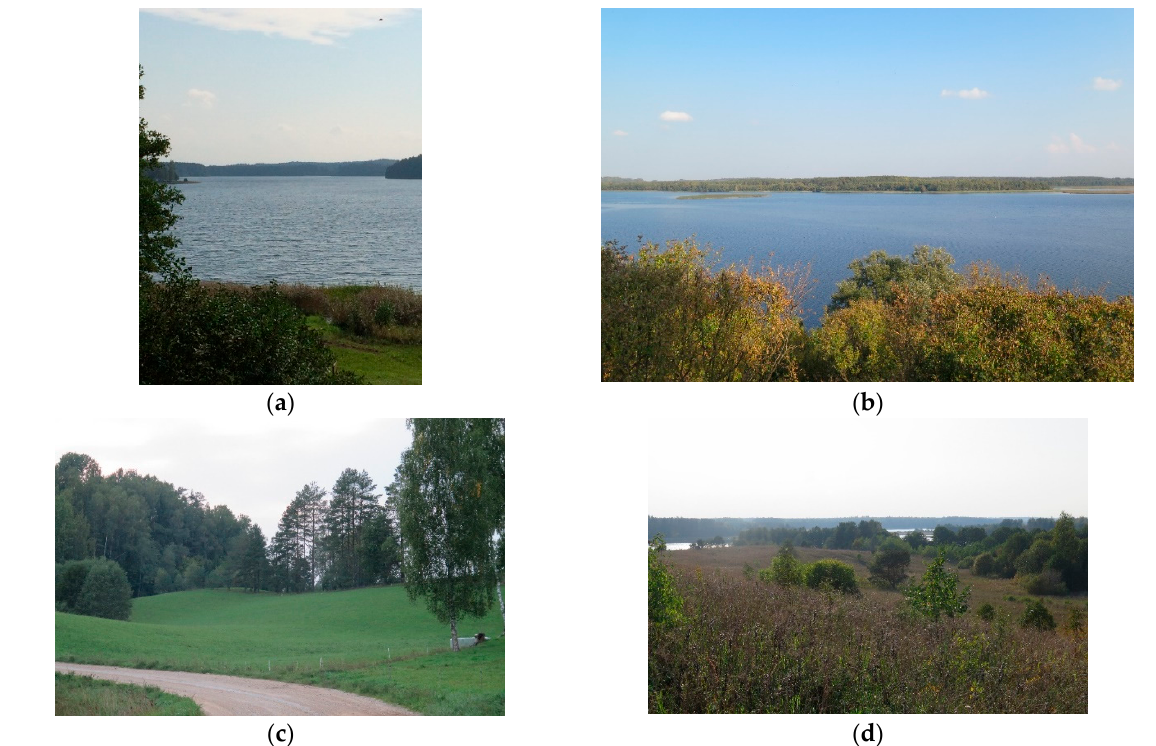
Figure 1. Locations and zoning of Karula national park (NP) in southern Estonia and Sebezhsky NP in the south of Pskov Region of Russia.